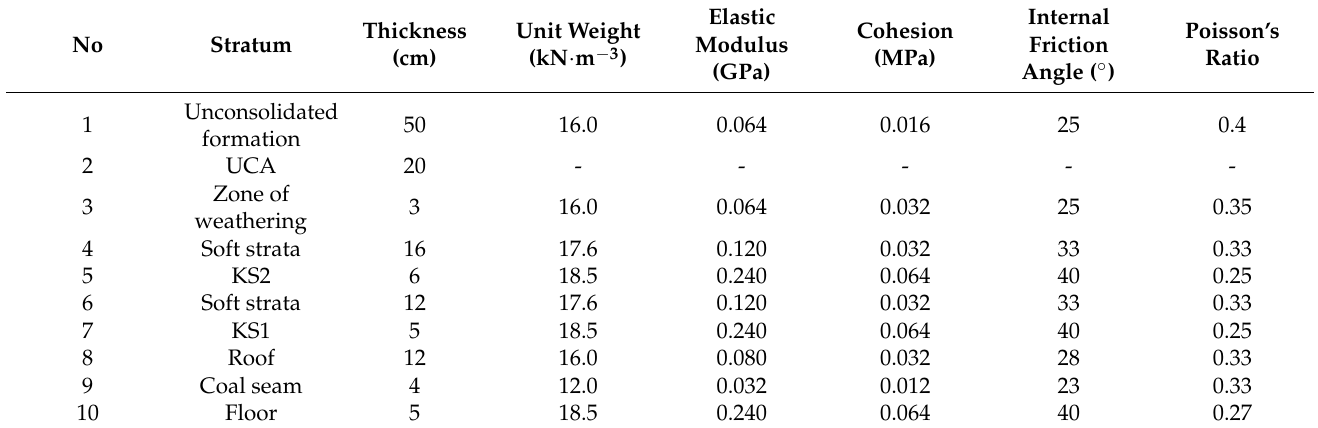
Table 2. Mechanics parameters of the overlying strata.